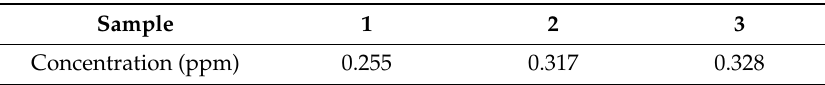
Table 2. Determination of Cu 2+ (ppm) in tap water.